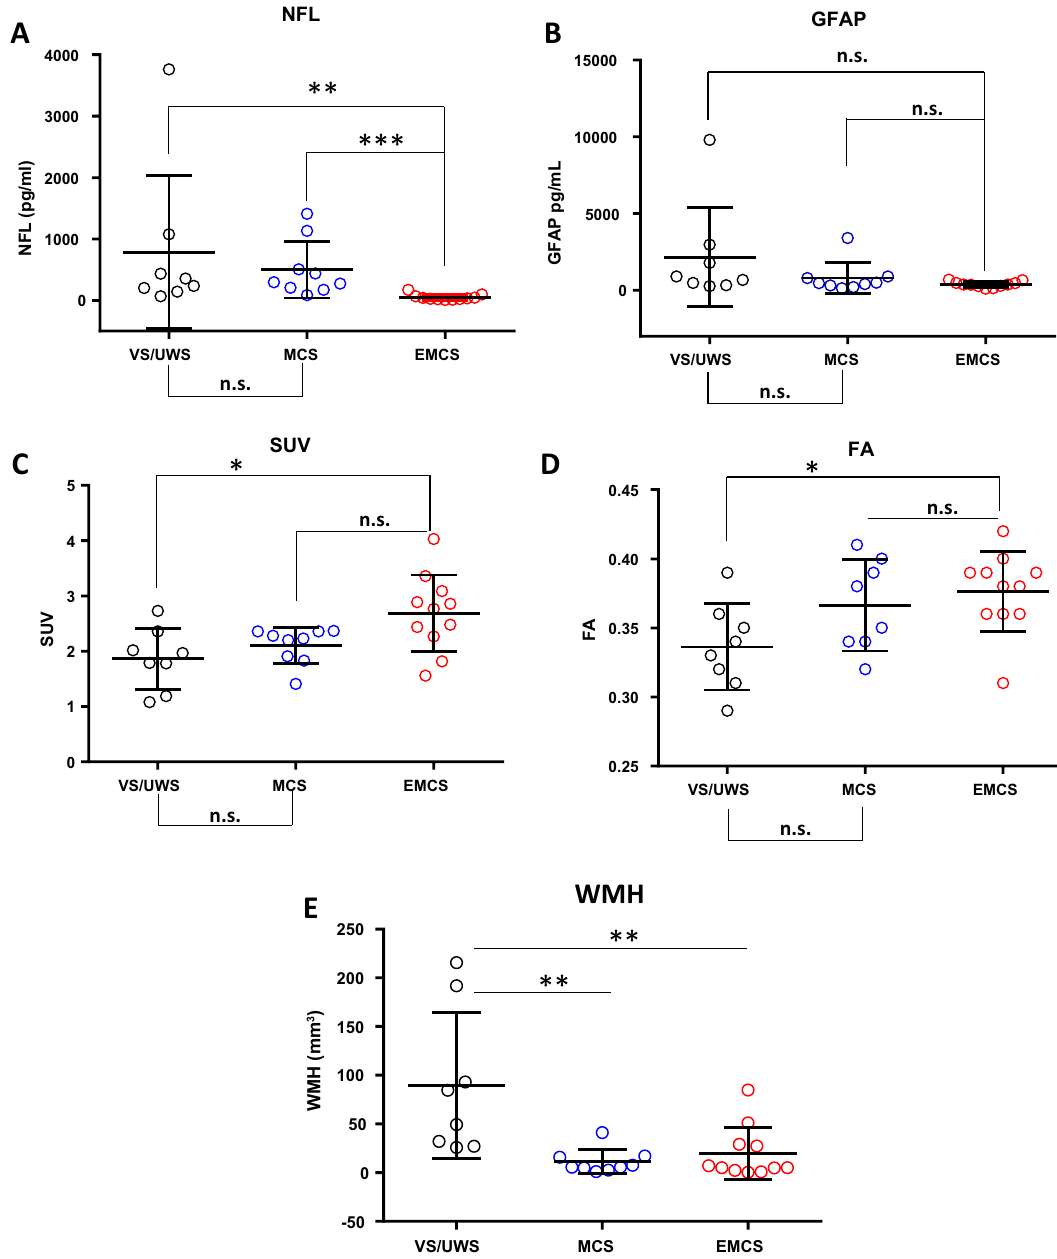
Figure 2. NFL ( A ), and GFAP ( B ) circulating biomarkers in pDoC patient subgroups. Whole-brain SUV (C) , FA ( D ) and WMH ( E ) imaging parameters obtained by PET-MRI. The values of selected markers were obtained from two independent measurements. * = p -value < 0.05. ** = p -value < 0.01. *** = p -value < 0. 001. One-way anova multiple comparison (Tukey’s method).n.s. = not significant. VS/UWS (Vegetative State/Unresponsive Wakefulness Syndrome). MCS (Minimally Conscious State). EMCS (Emergence from a Minimally Conscious